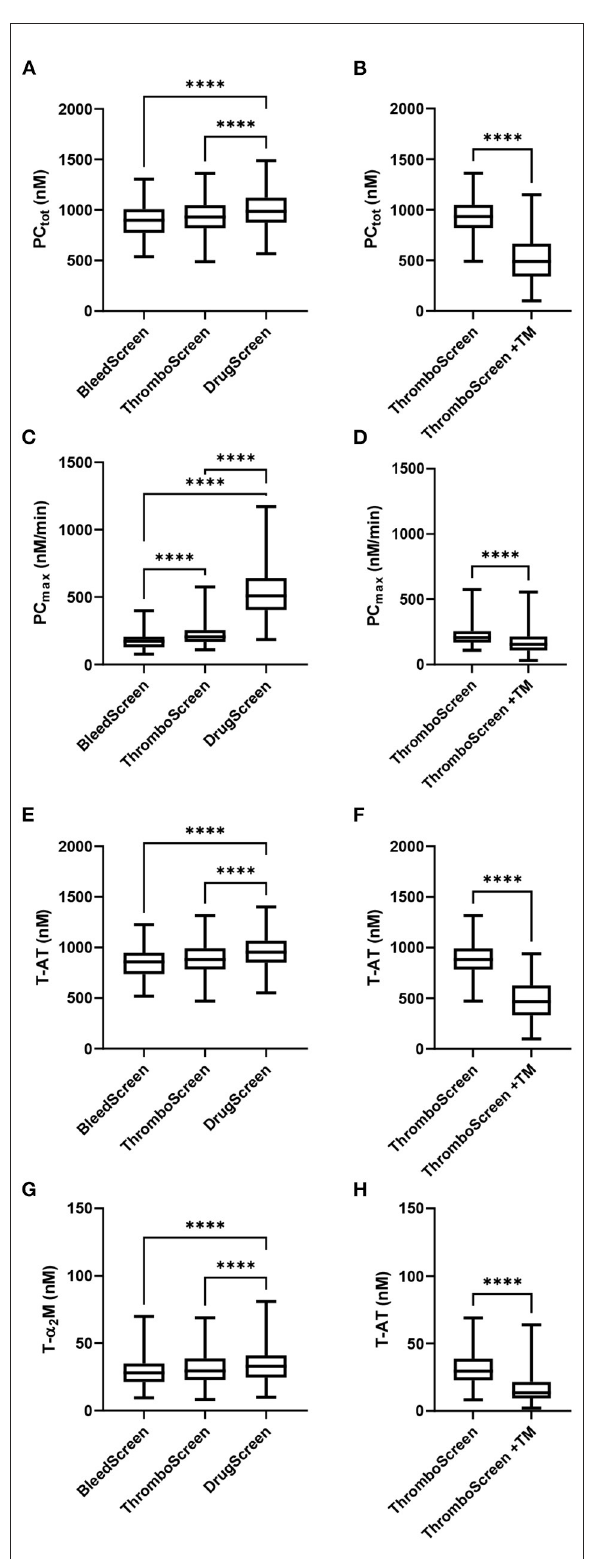
FIGURE1 Thrombin dynamics parameters obtained from thrombin generation data measured with the ST Genesia. TD analysis was